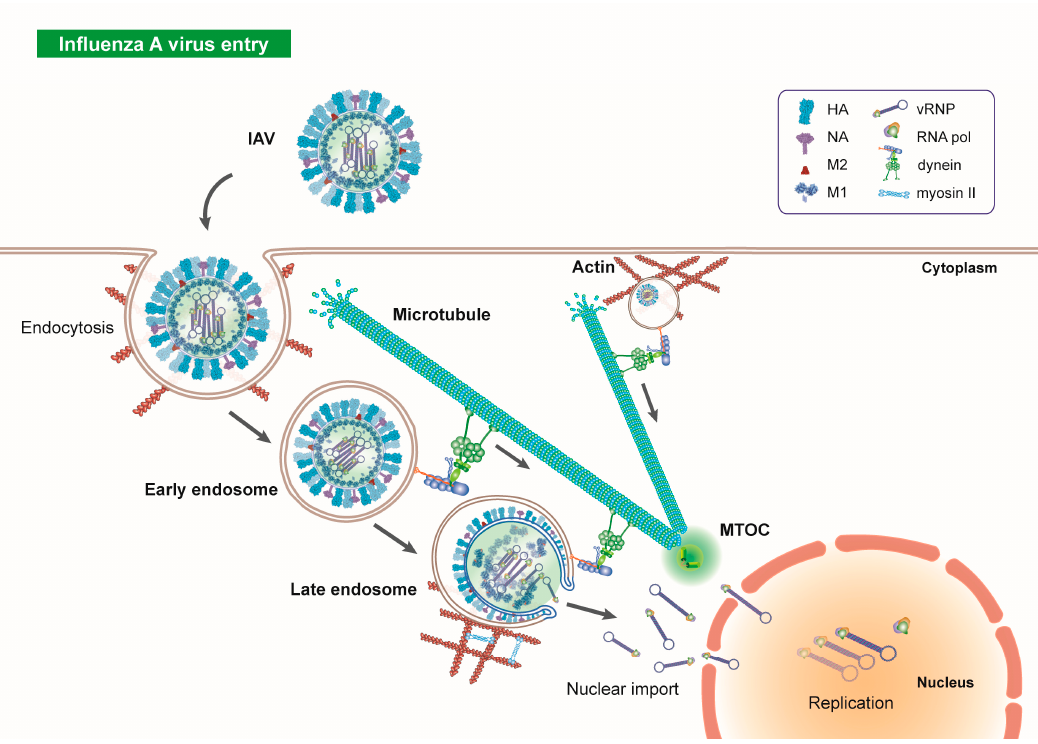
Figure 2. Influenza A virus endocytosis and early trafficking through the cell. IAV is a single-stranded negative sense RNA virus, belonging to the Orthomyxoviridae family. Viral particles are composed of an outer envelope containing the glycoproteins hemagglutinin (HA) and neuraminidase (NA) and M2 ion channels. An M1 shell constitutes the viral shell, within which are 8 viral gene segments each in association with nucleoprotein (NP) and an RNA polymerase. The influenza polymerase itself is formed from three subunits; PA, PB1 and PB2. Following attachment of IAV to permissive cells via sialylated cell-surface receptors, the virus is endocytosed via clathrin-mediated endocytosis and macropinocytosis. After initial association with the actin-myosin network, early endosomes containing IAV virions interact with microtubules via dynein motor proteins for retrograde traffic towards the MTOC, in close proximity to the cellular nucleus. Upon reaching the perinuclear region, IAVs undergo low-pH mediated fusion with the late endosomal membrane. M1 shell uncoating is dependent on microtubules, actin, and the motors dynein and myosin II. Release of vRNPs into the cytosol and uptake into the nucleus precedes viral genome replication. Three-dimensional structural data: PDB ID HA (2IBX); NA (6CRD); M2 (3BKD); M1 (1EA3) [65] .